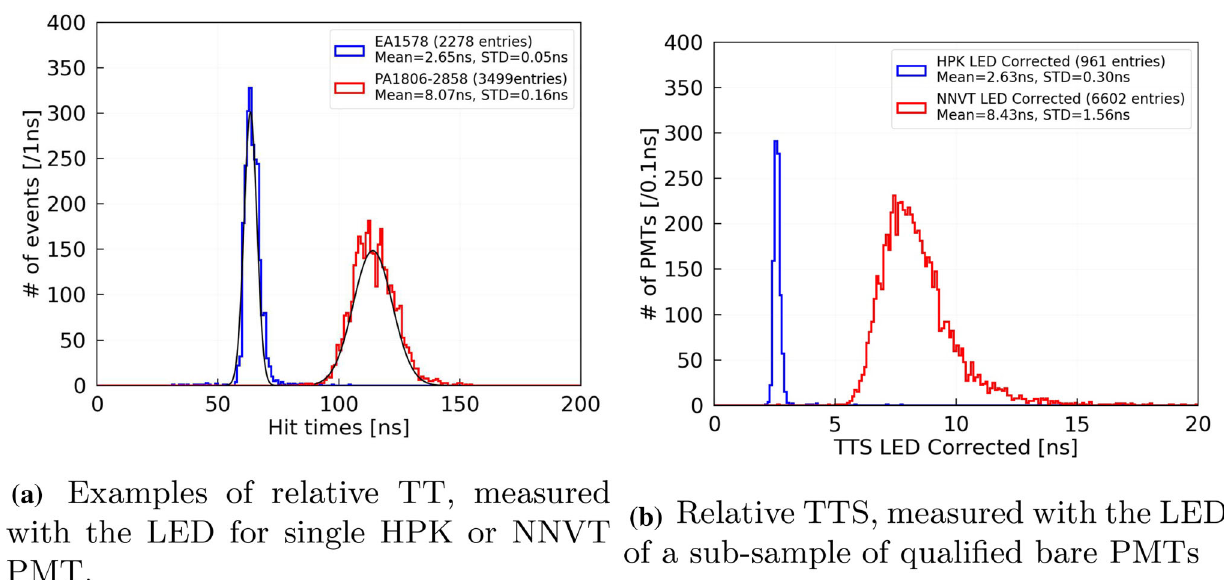
Fig. 27 Relative TT distribution from LED measurements of single PMT and the relative TTS distribution of sub-sample of all qualified bare PMTs measured with LED in the container system. Dark-green, NNVT PMT; blue, HPK PMT